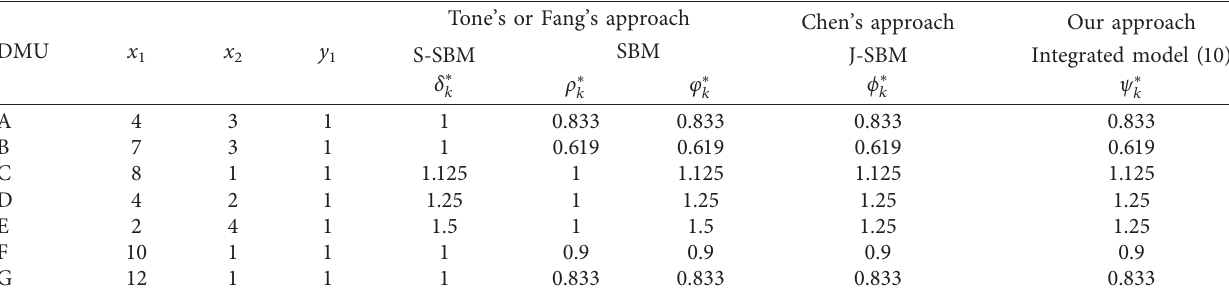
Table 1: Data set 1 from Tone